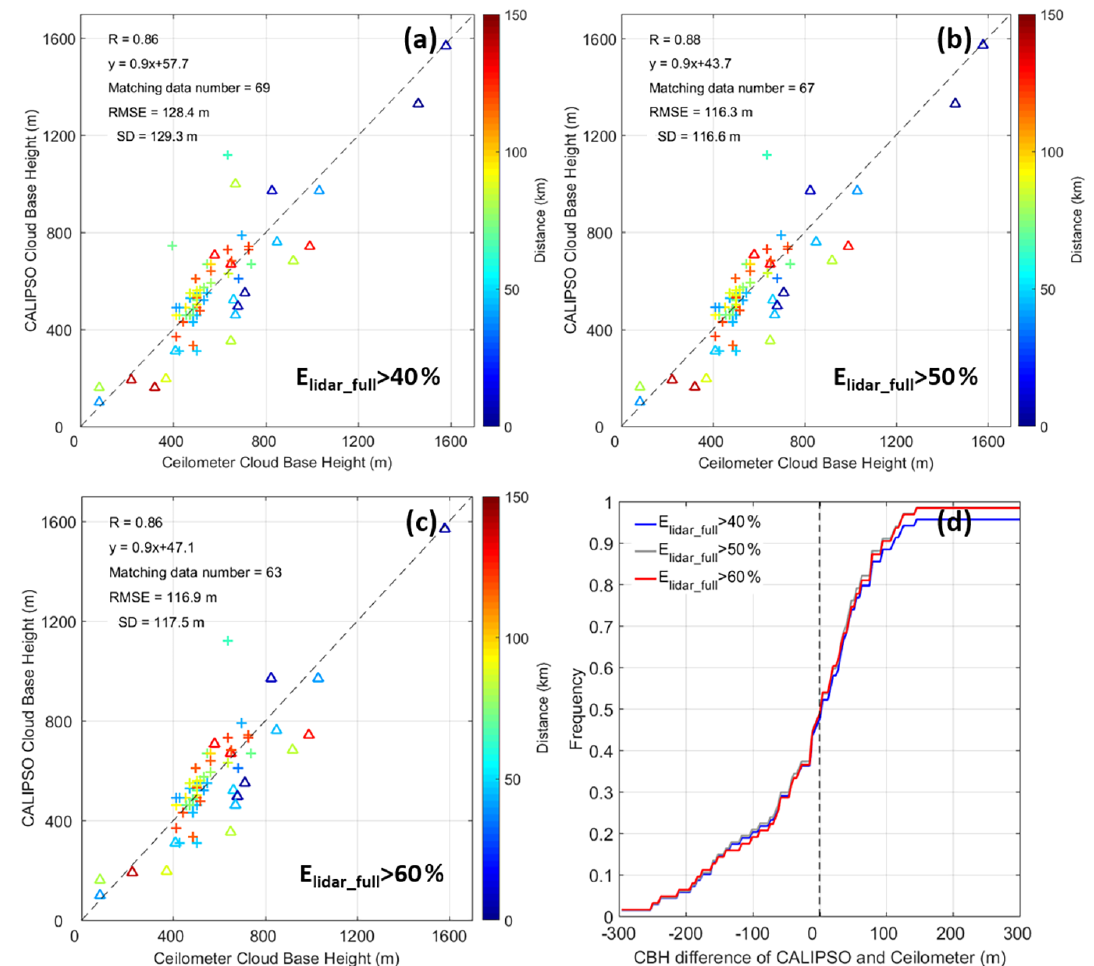
Figure 7. Same as Fig. 5 but (a) when penetration efficiency of full-resolution cloud features ( E lidar_full ) of one scene is larger than 40%; selection criteria of multilayer cloud fraction and penetration efficiency of 333m resolution cloud are the same as Fig. 6c at two marine sites in 2017. The triangle represents the data for the ENA site, and the crosses represent the data for the Barbados site. The color represents the shortest distance from the CALIPSO ground track to the ceilometer site. Panels (b) and (c) are the same as panel (a) , but the selection criteria of E lidar_full in panel (b) are larger than 50%, and in panel (c) they are is larger than 60%. (d) Cumulative distribution of the difference between CALIPSO CBH and ceilometer CBH at two sites in 2017. Different colored lines represent the cumulative distribution at different selection criteria of E lidar_full